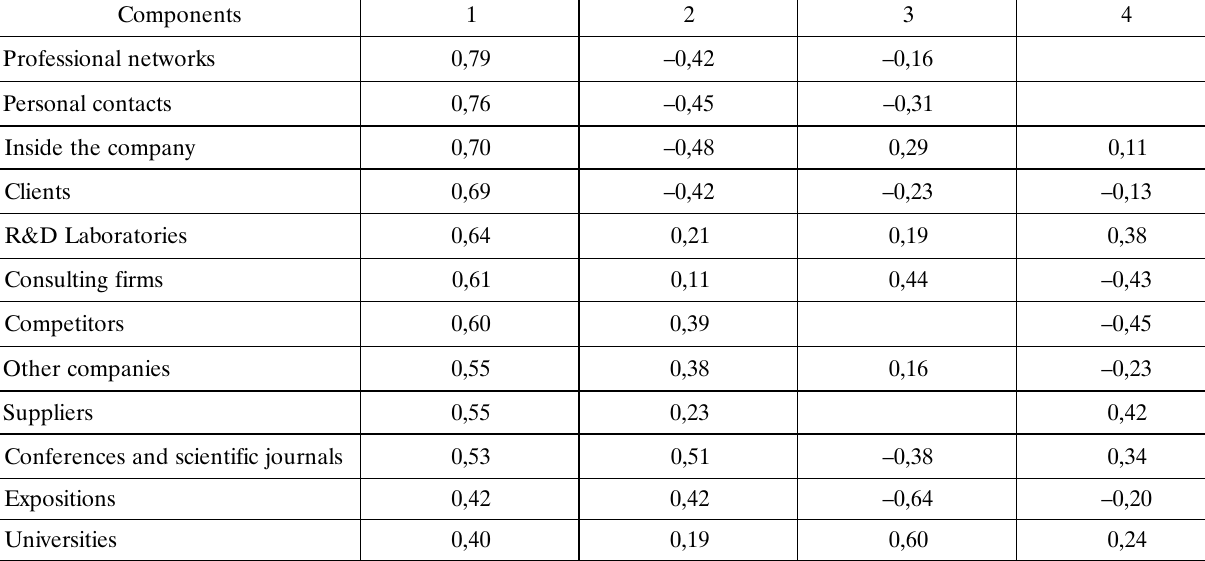
Table 6b. Factor Analysis – Information